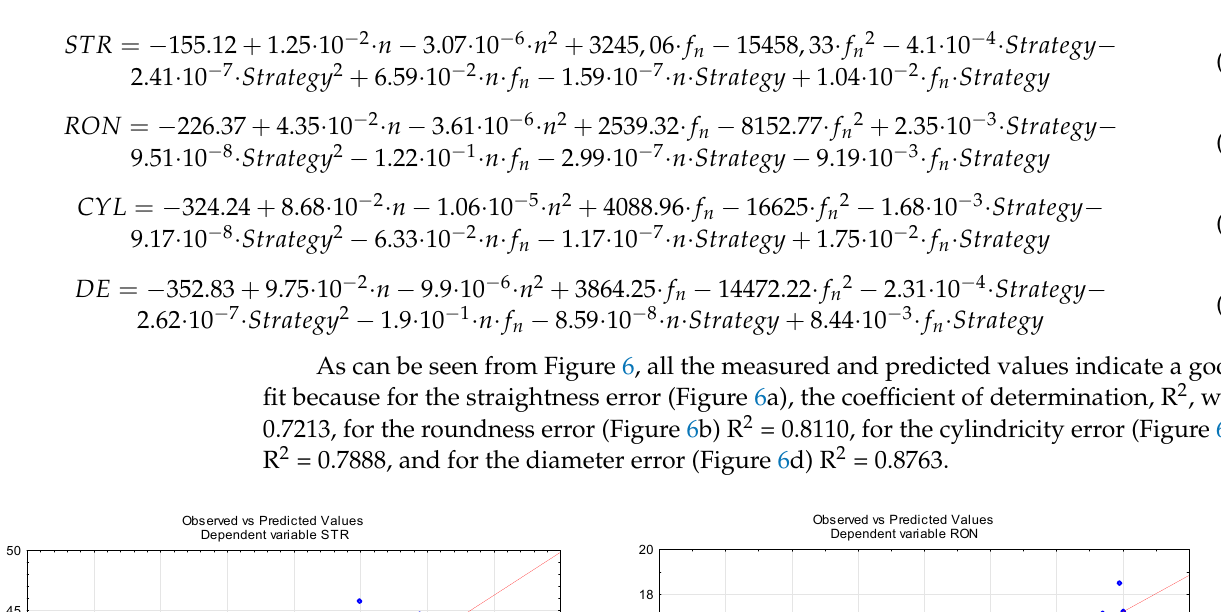
Table 5. Grey relational coefficients and Grey relational grade Experiment No.